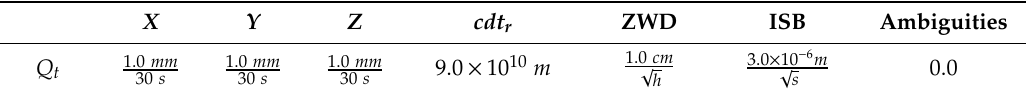
Table 1. Initial guess Q t for static PPP: ZWD is the zenith wet delay of the troposphere, ISB is the system time di ff erence with respect to GPS time. X Y Z cdt r ZWD ISB Ambiguities